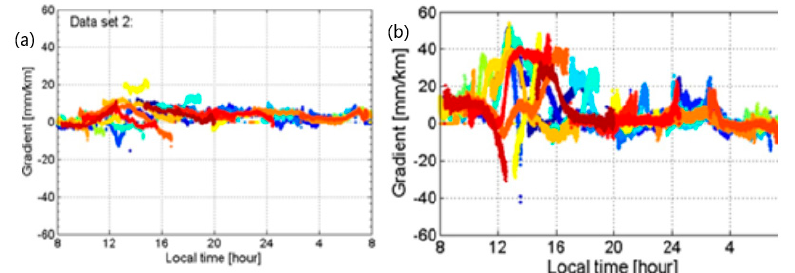
Figure 7. East–west gradient ( a ) and north–south gradient ( b ) for the ionospheric delay on 6 No- vember 2001 [9].